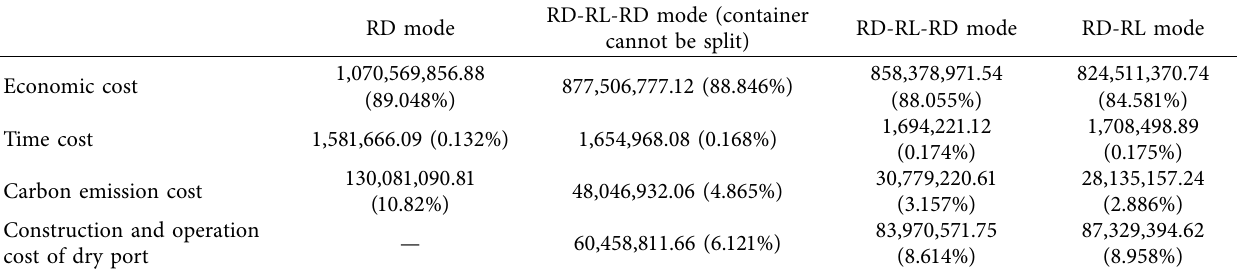
Figure 3: Hinterland area of the dry port under the road-rail Table 10: Cost of the different transportation modes and their proportion in total cost (unit: USD).